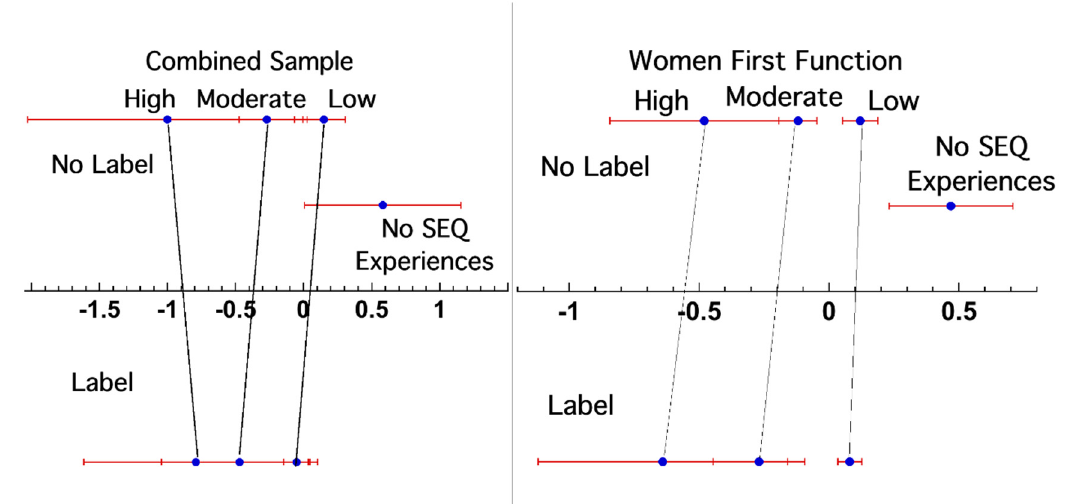
Figure 6. Discriminant group centroids of low, moderate, and high SEQ experience respondents, differentiated according to their sexual harassment self-label. Left panel is the “Combined Sample” (N = 689) of Magley et al., 1999 [16]. Right panel is the “Women First Function” (N = 19,615) of Munson et al., 2001 [17]. The whiskers represent the 95% (±2 σ ) variability of response.